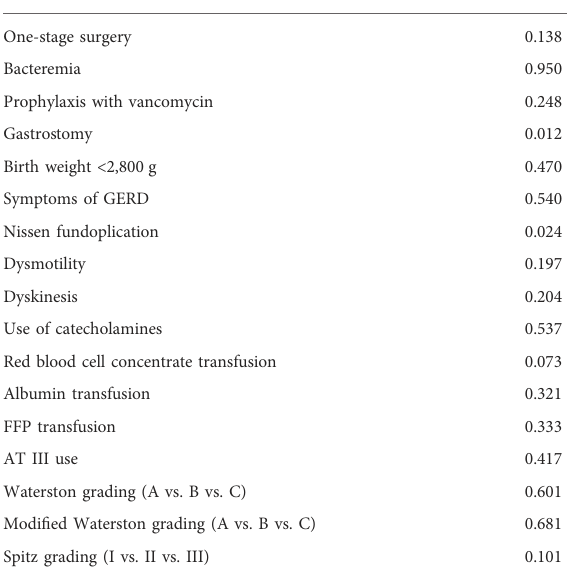
TABLE 10 Univariate logistic regression of risk factors of overall